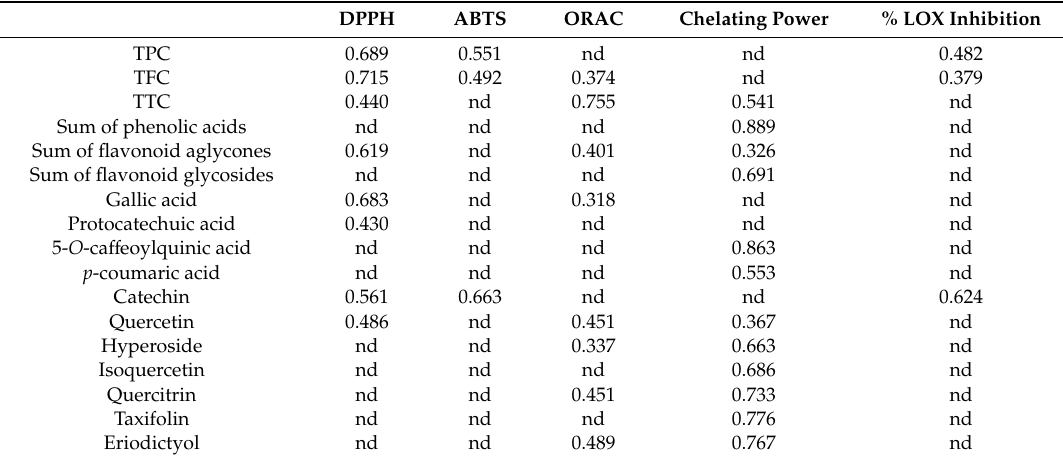
Table 5. Pearson’s correlation coe ffi cients between the biological activities and concentrations of secondary metabolites in di ff erent RL extracts. Abbreviations: total phenolic (TPC), total flavonoid (TFC), total triterpene content (TTC); nd—significant correlation not detected; other abbreviations as in Tables 3 and 4.